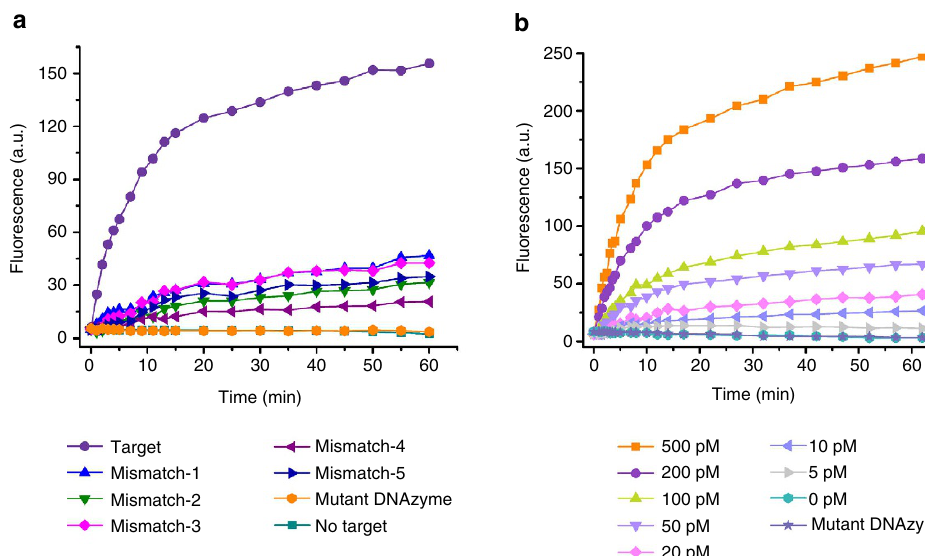
Figure 4 | Operating curves showing specificity and sensitivity of the DNAzyme motor. ( a ) Operating curves of the DNAzyme motor tested with the target DNA sequence and five variants of single-base mismatch. Sequences of the mismatch variants are shown in Supplementary Table 1. RSDs were 1.4–7.6%. ( b ) Operating curves of the DNAzyme motor in response to varying concentrations (0–500pM) of the target miRNA. Different concentrations (0–500pM) of the target miRNA were added into motor solutions each containing the equivalent of 230pM AuNP. The solutions were incubated for 20min to ensure the strand displacement reaction was completed. Then 500 m M Mn 2 þ was added into the solutions to activate the DNAzyme. The time at which Mn 2 þ was added is referred to as time 0. RSDs were 1.1–9.3%.